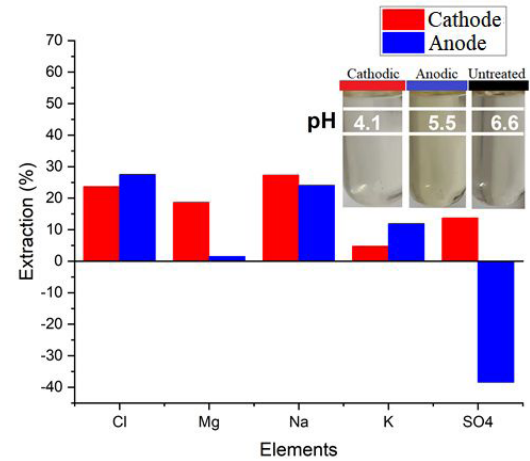
Figure 5. Extraction efficiency of Na, Mg, Cl, SO4 and K from HSW solution after plasma treatment and pH values (above) of the cathode, anode and untreated